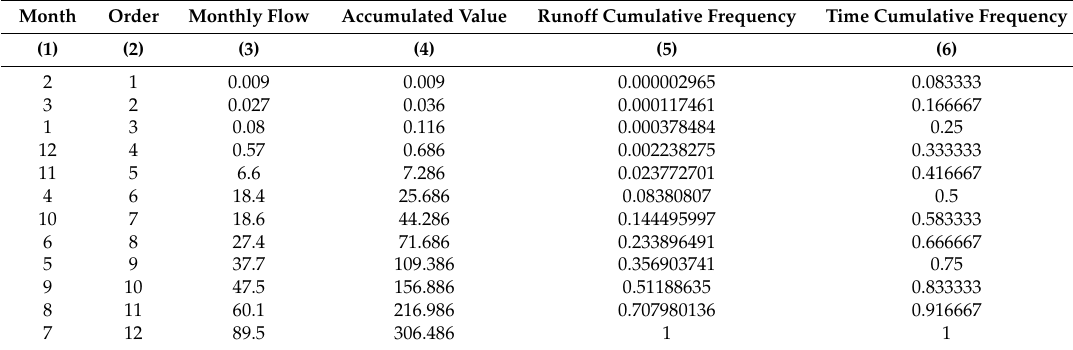
Table A2. Detailed calculation